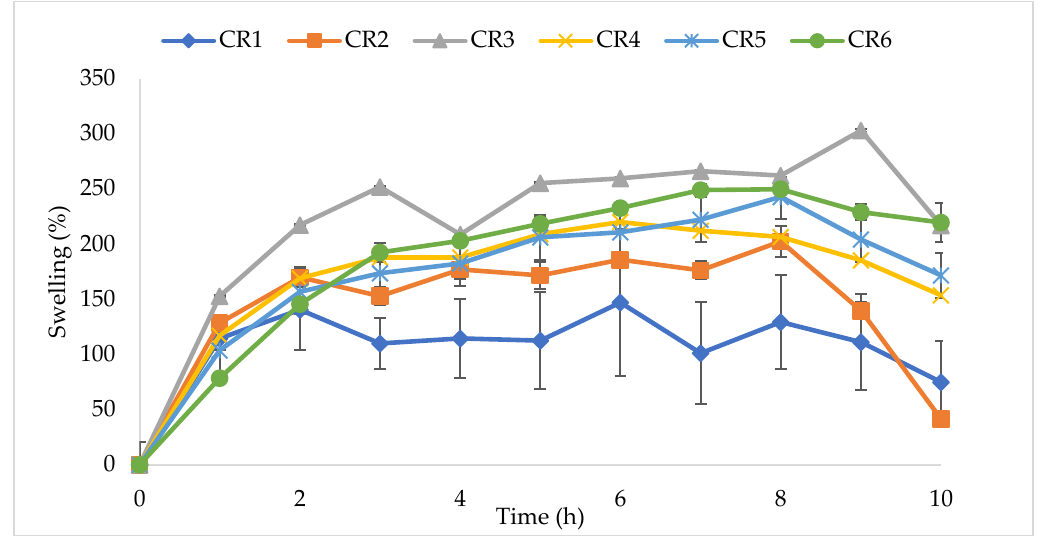
Figure 8. Swelling profiles for controlled release formulations CR1–CR6. Each data point is the mean ± standard deviation of the triplicate.